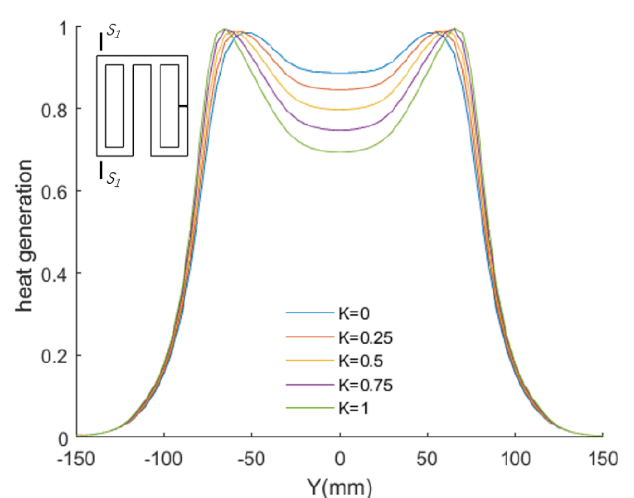
Figure 10. Heat generation in section S 1 –S 1 .